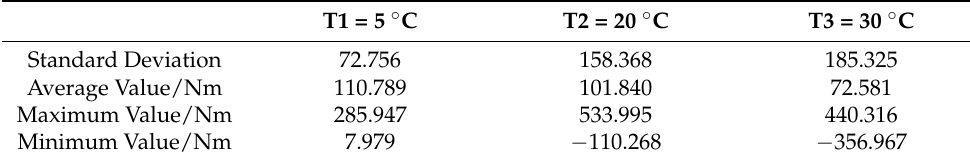
Figure 9. Effect of Ambient Temperature on NOx Emission Performance. Table 5. Influence of Ambient Temperature on Engine Torque.